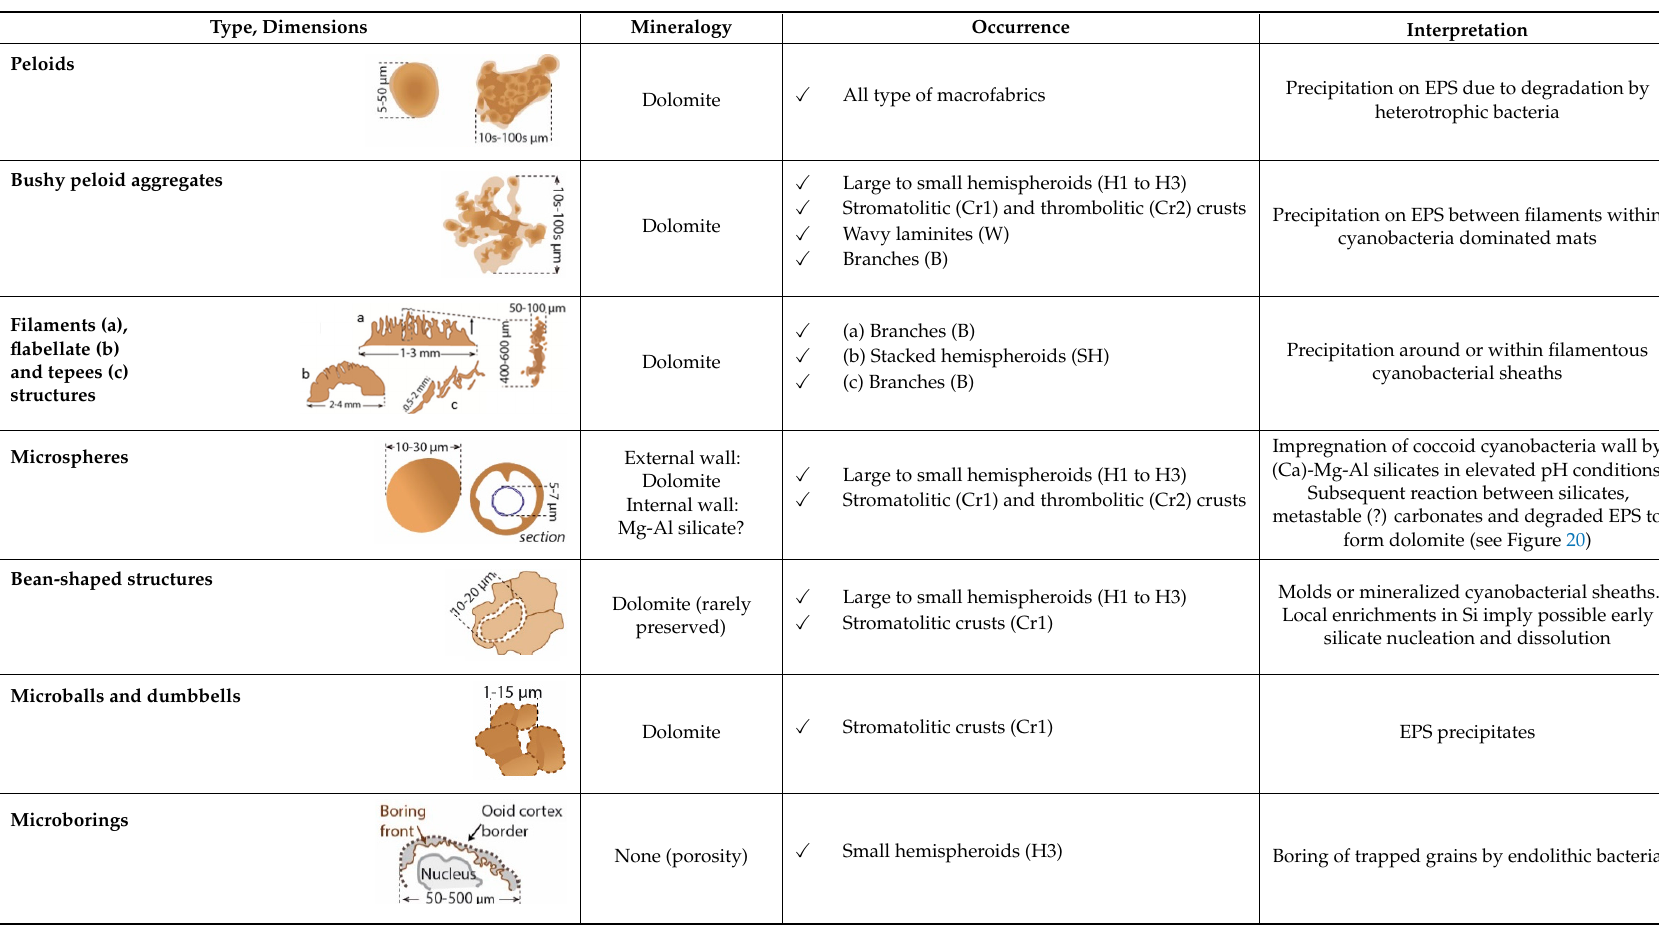
Table 2. Composition, size, and distribution of microbial microstructures and microfossils found in TCC microbialites. EPS, extracellular polymeric substances.